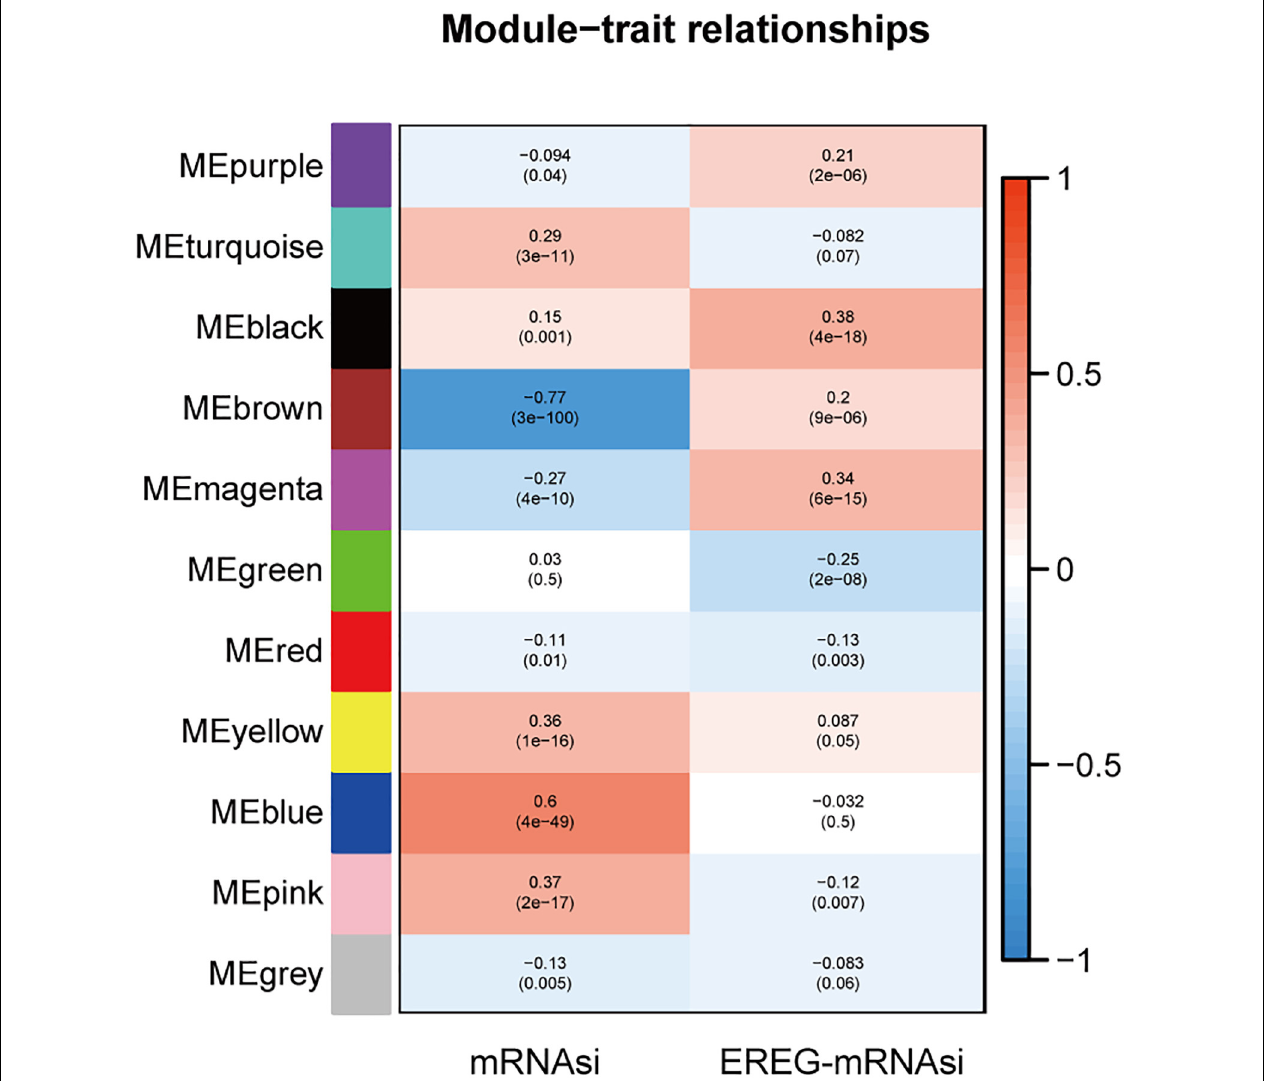
FIGURE 2 | The analysis of the weighted gene correlation network analysis (WGCNA) modules showed that there were ten sets of genes (modules) significantly associated with mRNAsi. The purple, brown, magenta, red, and gray modules were correlated negatively with mRNAsi.